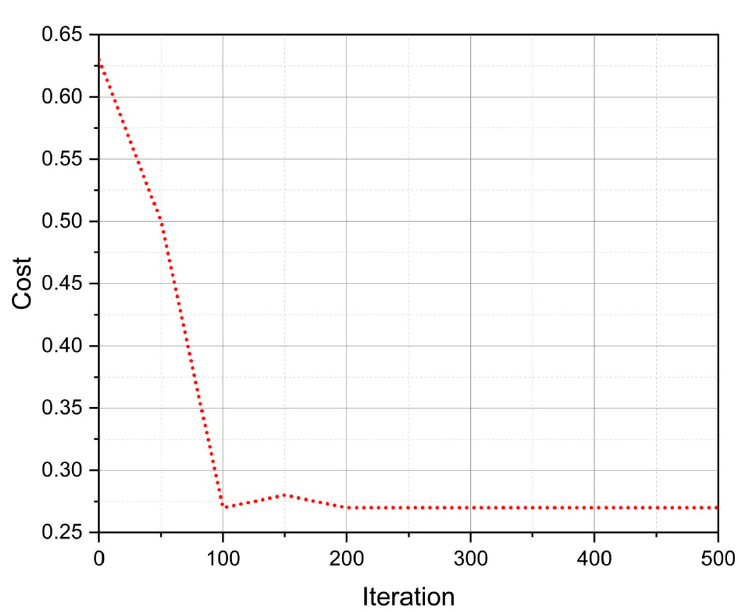
Figure 9. Convergence of the objective cost function in the ICO-DLNN model.